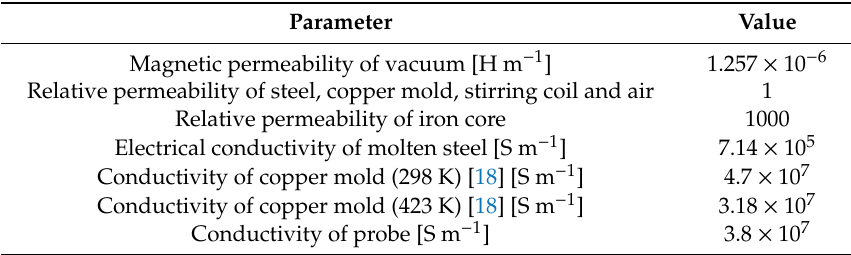
Table 2. Physical properties of material employed in this